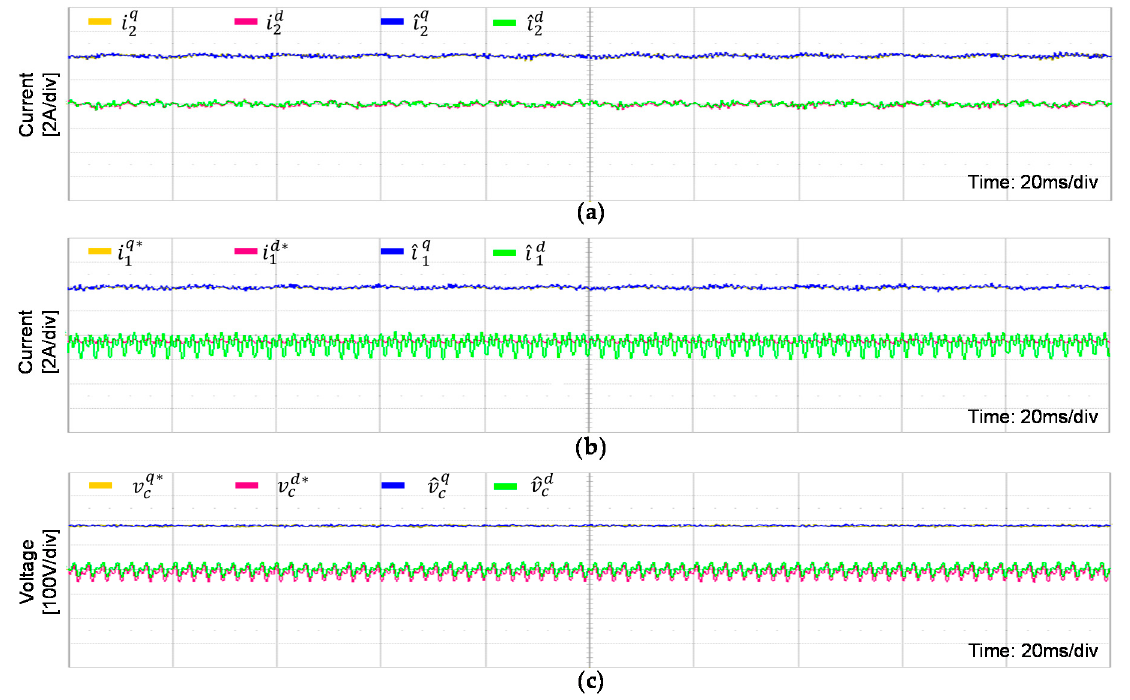
Figure 17. Experimental results of the proposed controller under three-phase distorted grid volt- ages. ( a ) Three-phase grid voltages; ( b ) FFT result of phase- a voltage; ( c ) three-phase grid currents; and ( d ) FFT result of phase- a current.